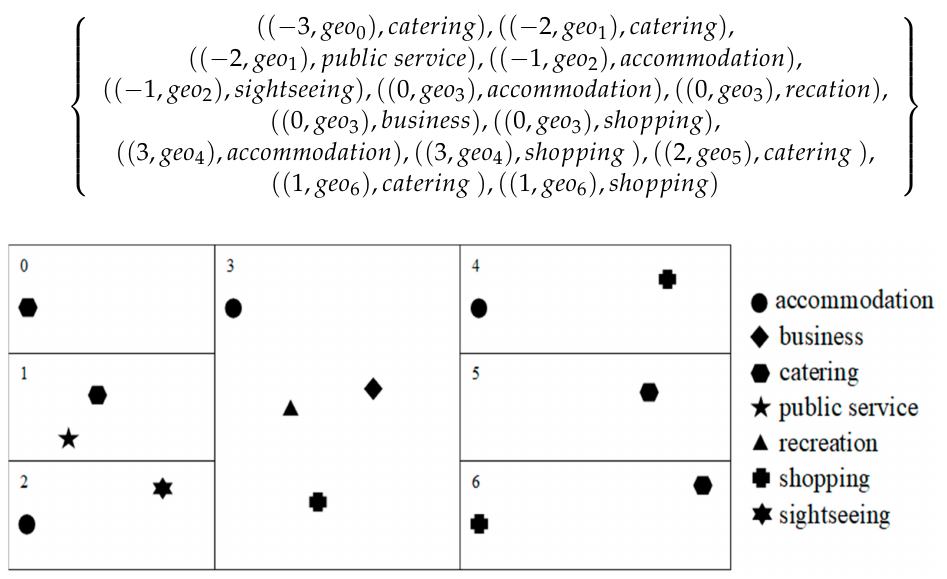
Figure 10. An example of POI